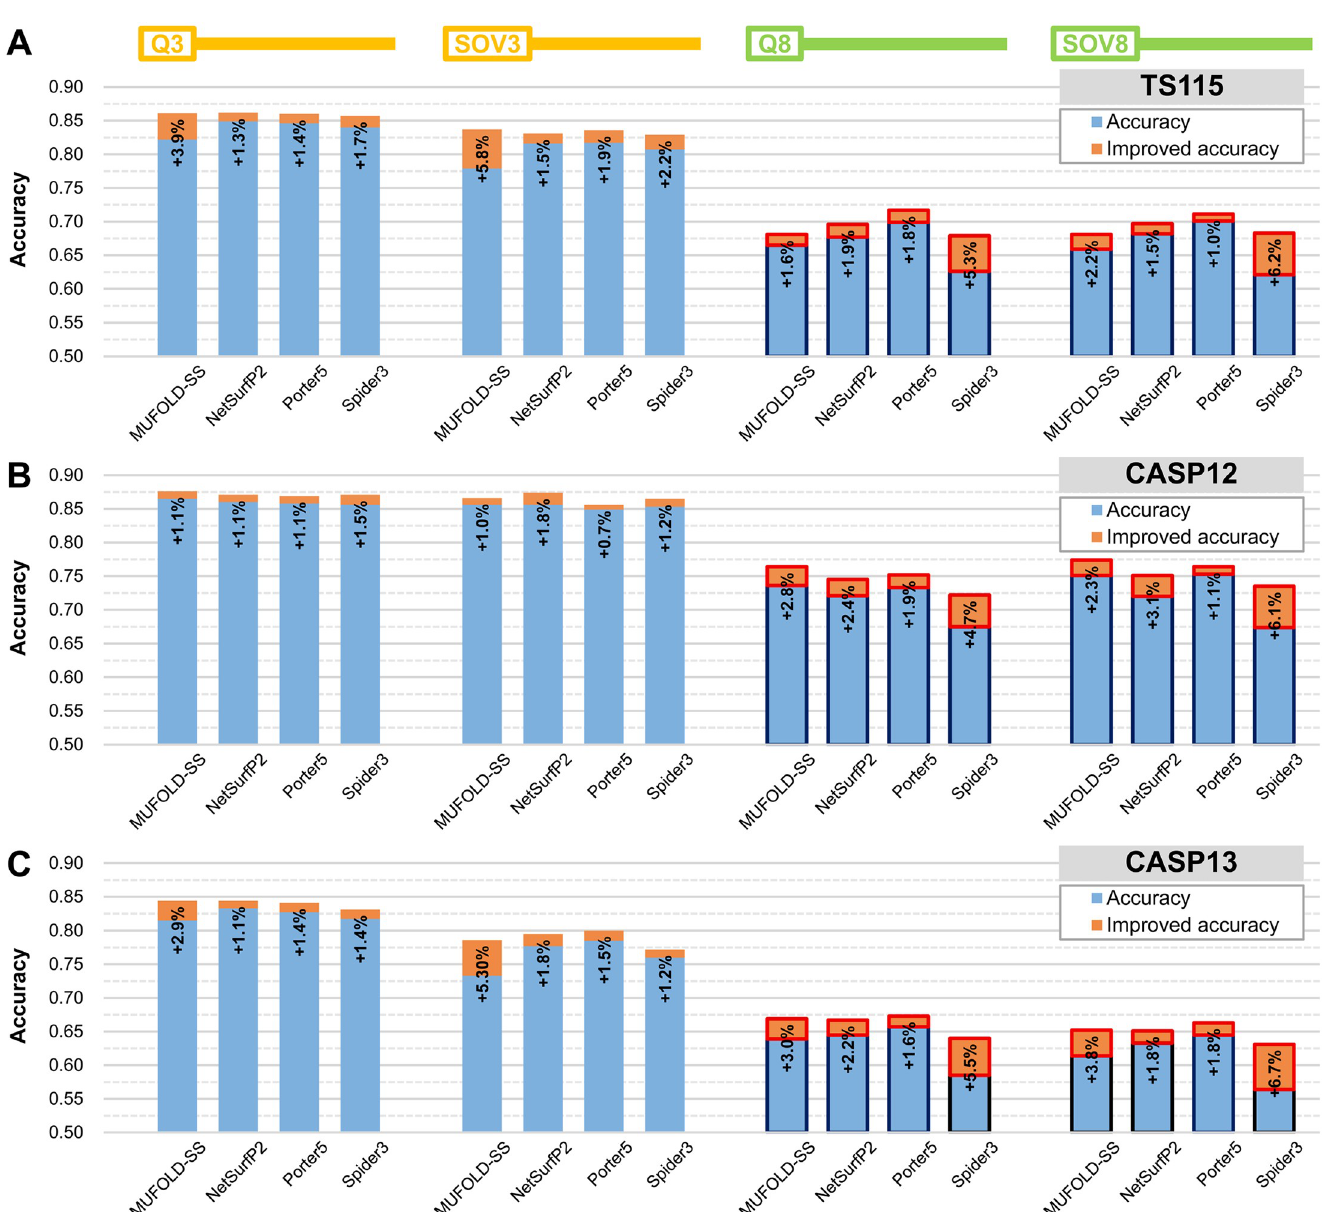
Fig 3. Performance of preliminary incorporation of SSE-PSSM into state-of-the-art SSP methods using HHBlits to generate PSSM. (A) TS115 against the UniRef90-2015 PSSM target dataset. (C) CASP12 against UniRef90-2015. (D) CASP13 against UniRef90-2015. These methods used HHBlits as the main PSSM generator. Except for NetSurfP-2, the PSI-BLAST PSSM was also applied in their algorithms. We used both HHBlits and PSI-BLAST to implement the SSE-PSSM and preliminarily integrate it with these HHBlits-based SSP methods. Their accuracies were higher than those of the algorithms tested in Fig 2. However, since their programs were released after 2017 and TS115 and CASP12 proteins were released before 2017, they might have learned some homologs of these datasets. Thus, the CASP13, which comprised proteins released between 2017 and 2019, should be the most reliable independent test dataset among the three. Assessed with CASP13, the preliminary feature integration of SSE-PSSM into these HHBlits-based methods improved the Q3 and Q8 by 1–3% and 2–6%, respectively. and 67.2%, respectively. After integration, the average Q3 and Q8 increased to 85.7% (+1.6%) and 70.0% (+4.3%), respectively. In general, the performance of these HHBlits-based algo- rithms in SOVs was weaker than in Q measures. The improving effect of SSE-PSSMhh for the assessed four SSP algorithms on the SOV3/8 accuracies was +2.2%/+3.1% on average.